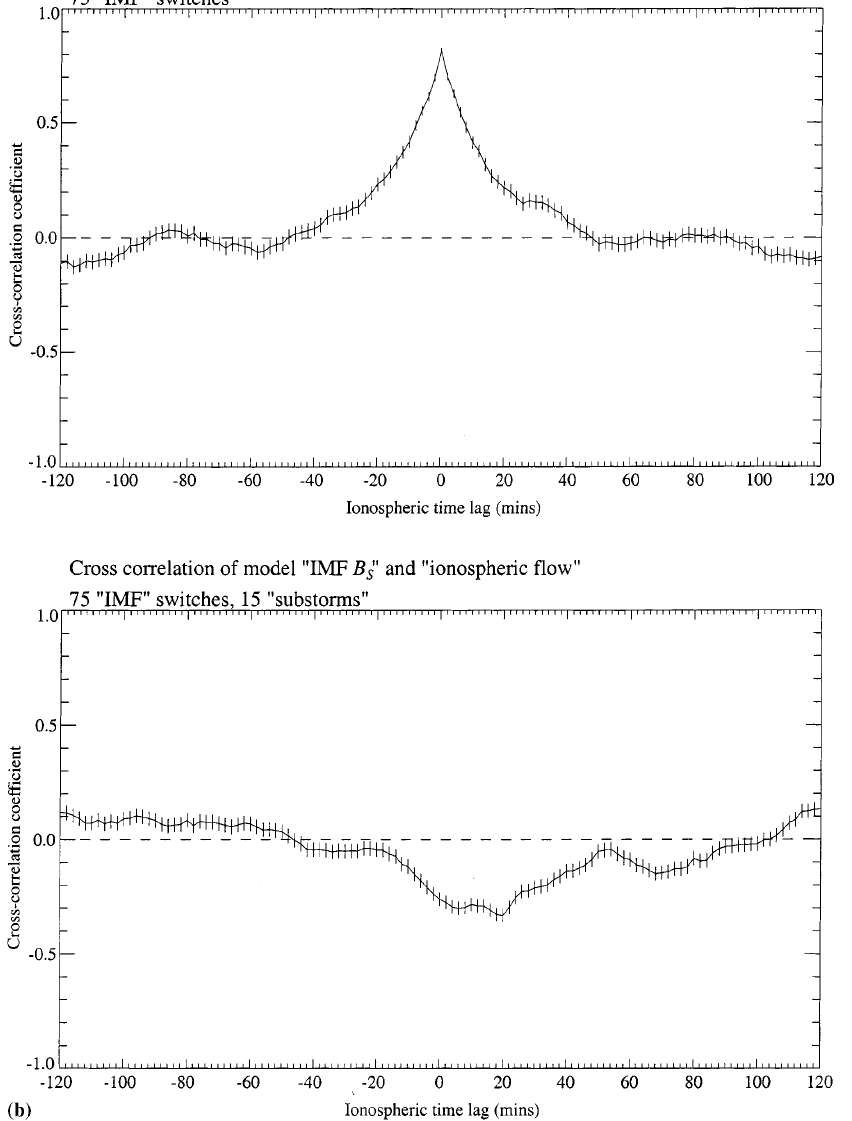
Fig. 3. b Cross-correlograms corresponding to the two synthetic ‘‘IMF’’-’’ionospheric velocity’’ data sets shown in a . The upper panel corresponds to the ‘‘velocity’’ data shown in the middle panel of a , while the lower panel corresponds to the ‘‘velocity’’ data shown in the lower panel of